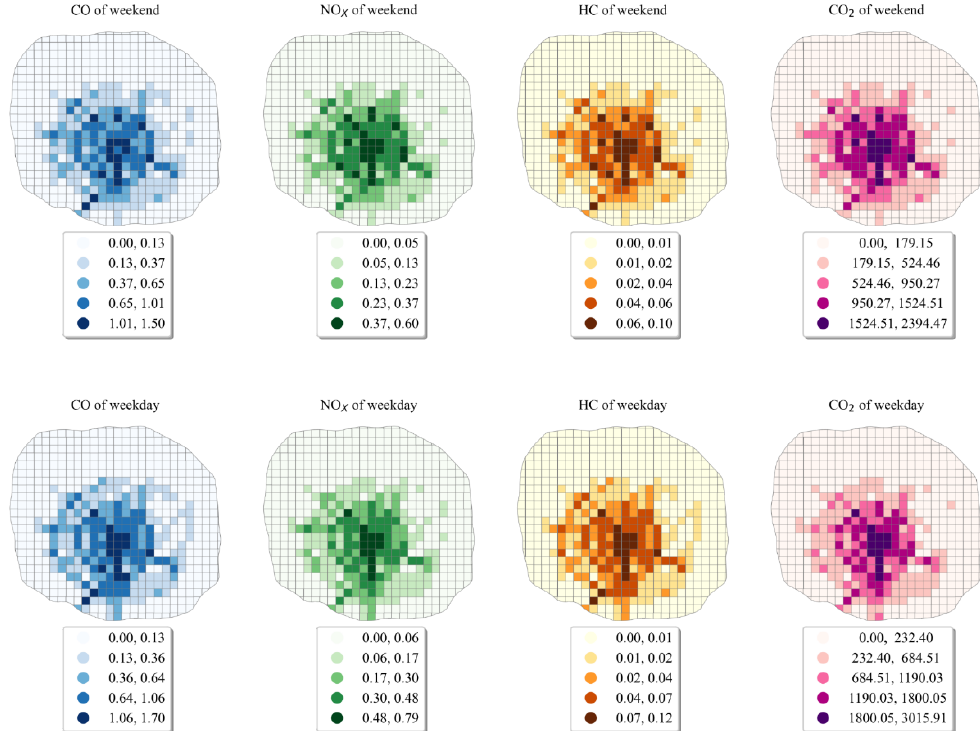
Figure 5. The emission distribution map (unit: kg).